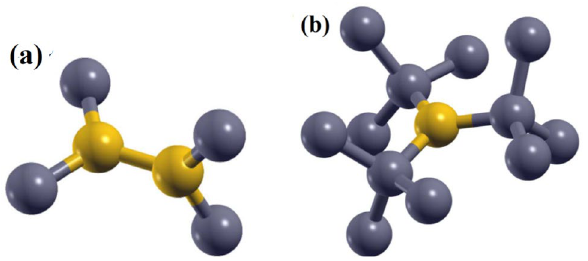
Figure 13. ( a )Two threefold atoms bonded but their p orbitals are rotated relative to each other, and ( b ) a threefold carbon atom surrounded by fourfold atoms 55 .